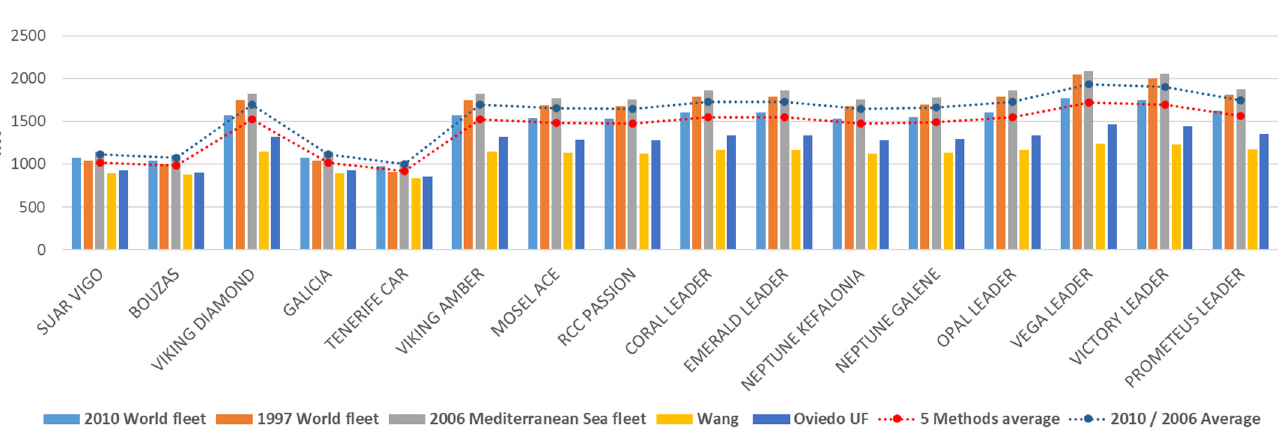
Table 10. Auxiliary engines(cid:31) consumed power (kW) estimate considering load factor of 0.4.